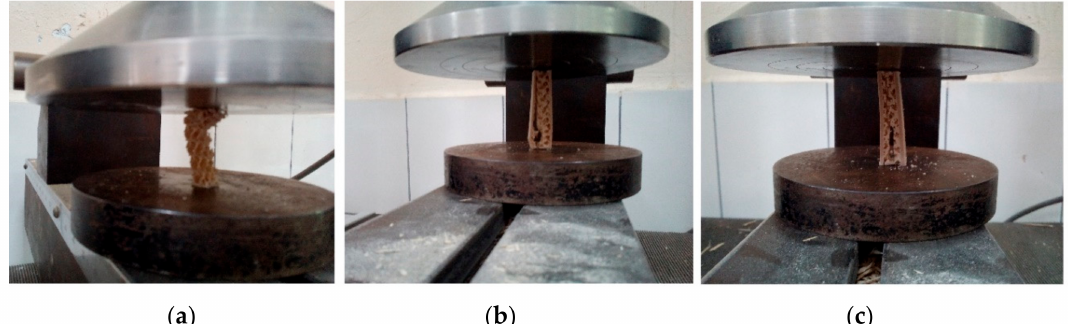
Figure 4. Typical failure modes of compressive test specimens. ( a ) gyroid core without skin; ( b ) Specimens with 1 mm thick skin (vertical failure was between core and skin); ( c ) Specimens with 2 mm thick skin (vertical failure was in the core).